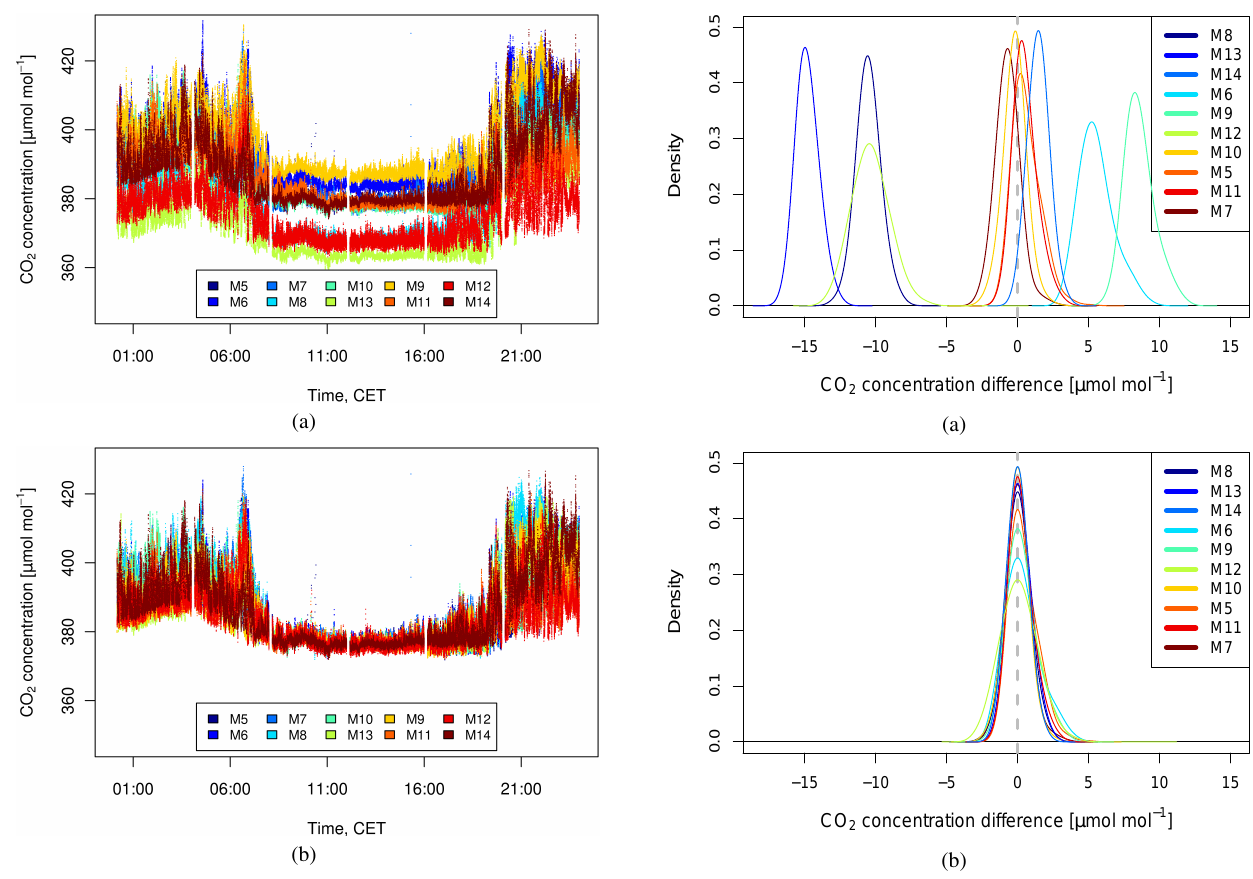
Fig. 7. Density distribution of concentration differences c i ( t ) − ˜ c ( t ) using measured 60-minute concentration timeseries c i ( t ) before bias correction (a) and after bias correction (b) . Number of sam- ple locations n = 10 (M5 , M6 ,..., M14), sampling resolution 1 Hz, on 29 June 2008, 12:00-13:00. Legend indicates measurement lo- cations according to Fig.1.